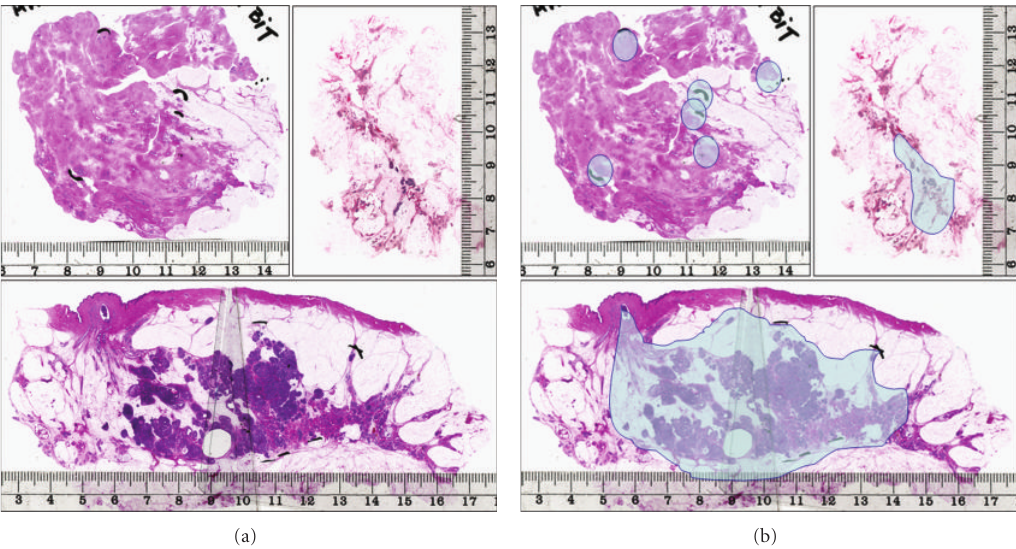
Figure 1: The three basic growth patterns of in situ carcinoma within the sick breast lobe. Upper left: the peripheral pattern; upper right: the segmental pattern; lower image: the lobar pattern. The structures involved by in situ carcinoma, corresponding to the extent of the disease, are marked in the series of images on the right-hand